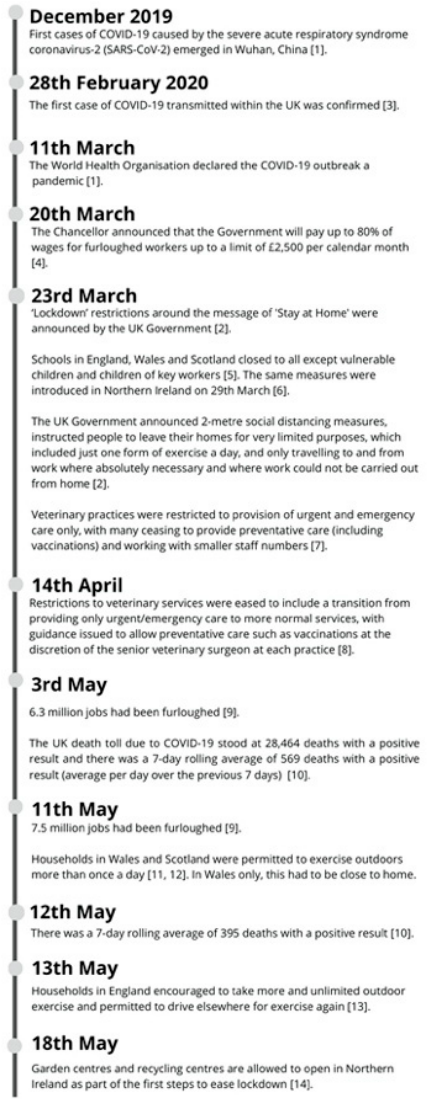
Figure 1. Statistics and dates relevant to this study across the four UK nations [1–14]. During the strict lockdown period (23rd March–11th/13th/18th May 2020 in Scotland and Wales, England, and Northern Ireland, respectively), people were only permitted to leave their home to shop for essential supplies (i.e., food and medicine), essential work (where remote work was not possible), medical needs, to provide care for vulnerable peo- ple and to take just one exercise outing away from home per day. Dog walking was not explicitly addressed in the government guidelines for daily exercise restrictions for Eng- land [15]; however, local public health officials in some areas of England did confirm that the daily exercise restrictions applied to dog walking [16]. In England, dog owners expe- riencing symptoms or diagnosed with COVID-19 were asked to exercise their dog(s) at home, and if not possible, arrange for someone else to walk their dog [17]. Similar guid- ance was implemented in Wales [18]. Guidelines for Scotland explicitly recognised that dog(s) may need to be taken out more than once a day in order to toilet, and explicitly advised shielding or vulnerable people to avoid walking their dog(s) [19]. By contrast, the